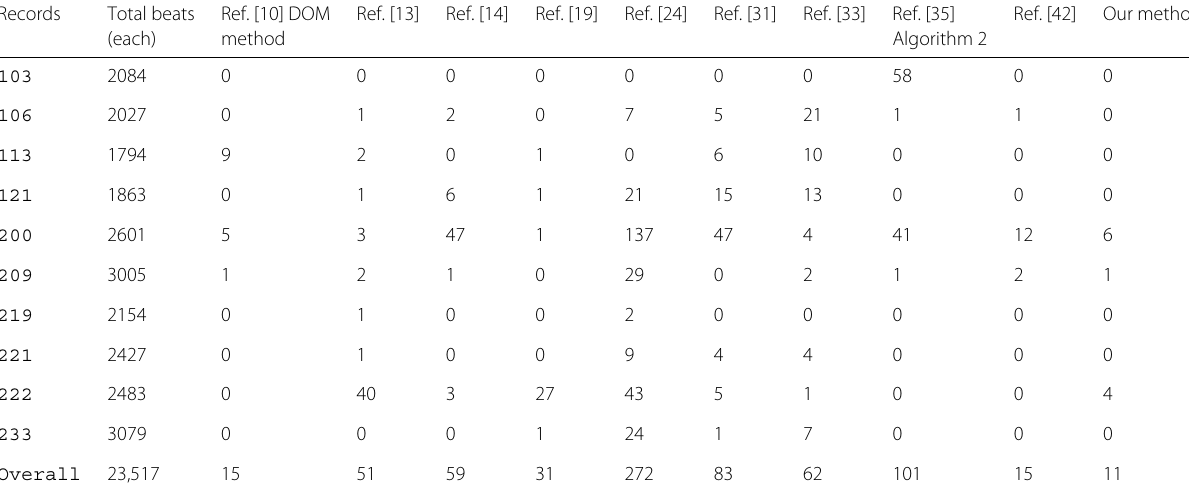
Table 3 Numbers of false-positives (FPs) comparison for specific records